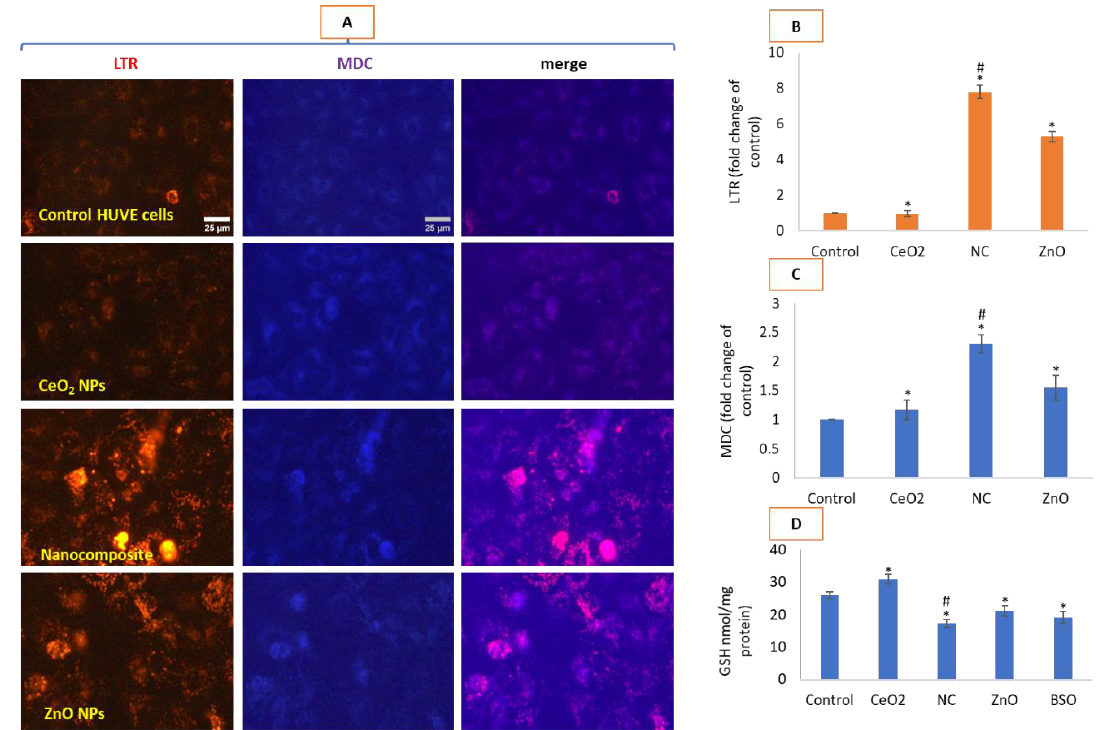
Figure 6. Autophagic vesicles were visualized by LTR (red fluorescence images) and MDC (blue fluorescence images) co-staining in HUVE cells ( A ) treated with NPs for 24 h. Fluorescence quantifications for LTR and MDC, respectively, are given in ( B ) and ( C ). Merge refers to the images obtained after color merging of LTR and MDC images in ImageJ. Antioxidant GSH modulation due to NPs is given in ( D ) where BSO stands for buthionine-(S,R)-sulfoximine which is an inhibitor of an enzyme involved in GSH synthesis. Scale bar represents 25 µm (40× objective). Each experiment was performed in triplicates ( n = 3). *statistically significant difference from the control ( p < 0.05). # statistically significant difference in between treatments of CeO 2 -Zn nanocomposite and ZnO NP ( p < 0.05).